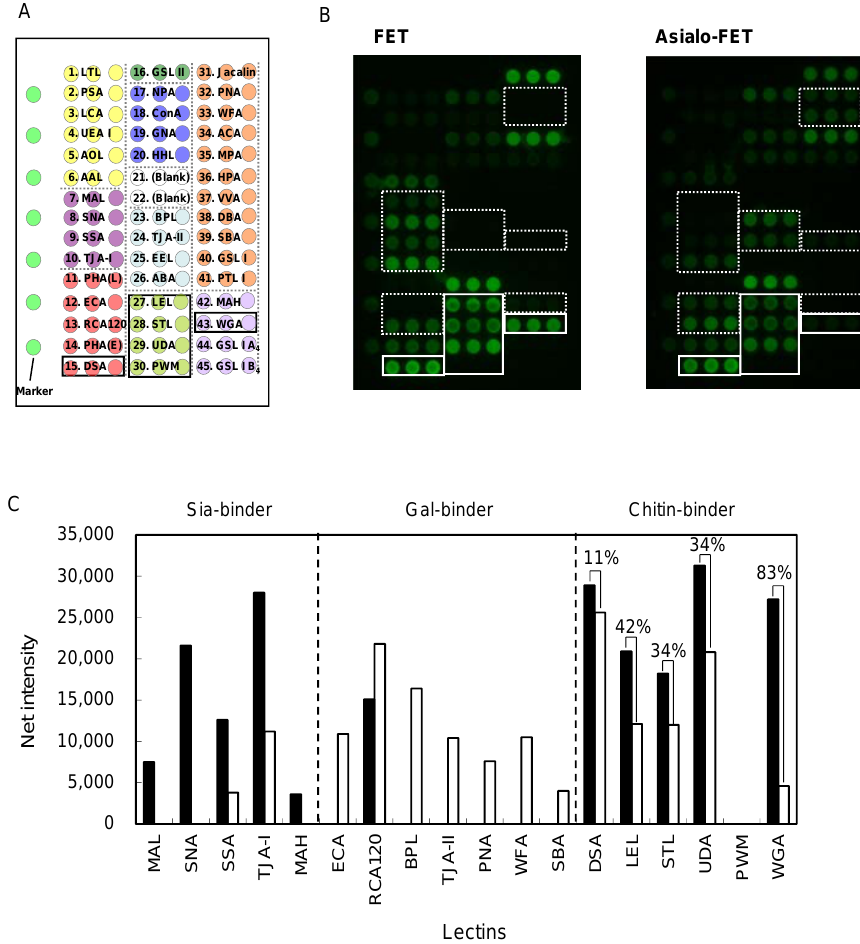
Figure 8. Lectin microarray analysis to observe the effect desialylation of a serum glycoprotein, fetuin (FET). Spot pattern of the lectin microarray; 43 lectins containing the six chitin-binding lectins were spotted on a glass slide, where different colors represent different glycan-binding specificities ( A ); Signal patterns obtained for FET and asialo-FET ( B ); Regions of chitin-binding lectins are indicated with boxes with solid lines and regions lectins showing altered signals by sialidase treatment are indicated with dotted lines. Bar graph representation of signal intensities of relevant lectins both before (closed bars) and after (open bars) sialidase treatment ( C ). Values above bars in the chitin-binding lectins show % reduction in the signal intensities after sialidase